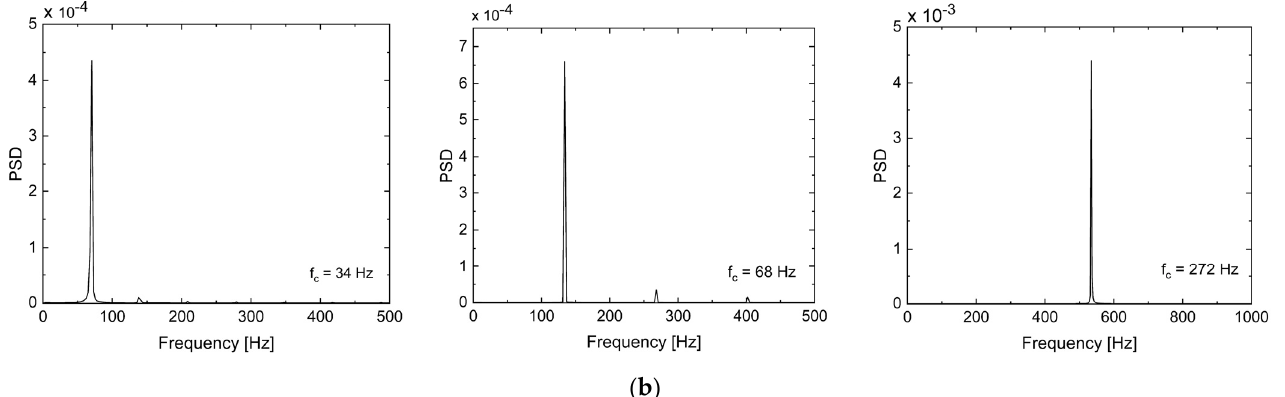
Figure 25. Spectral analysis of drag coefficient with an unsteady jet at different control frequencies. ( a ) C D signal; ( b ) PSD of C D .